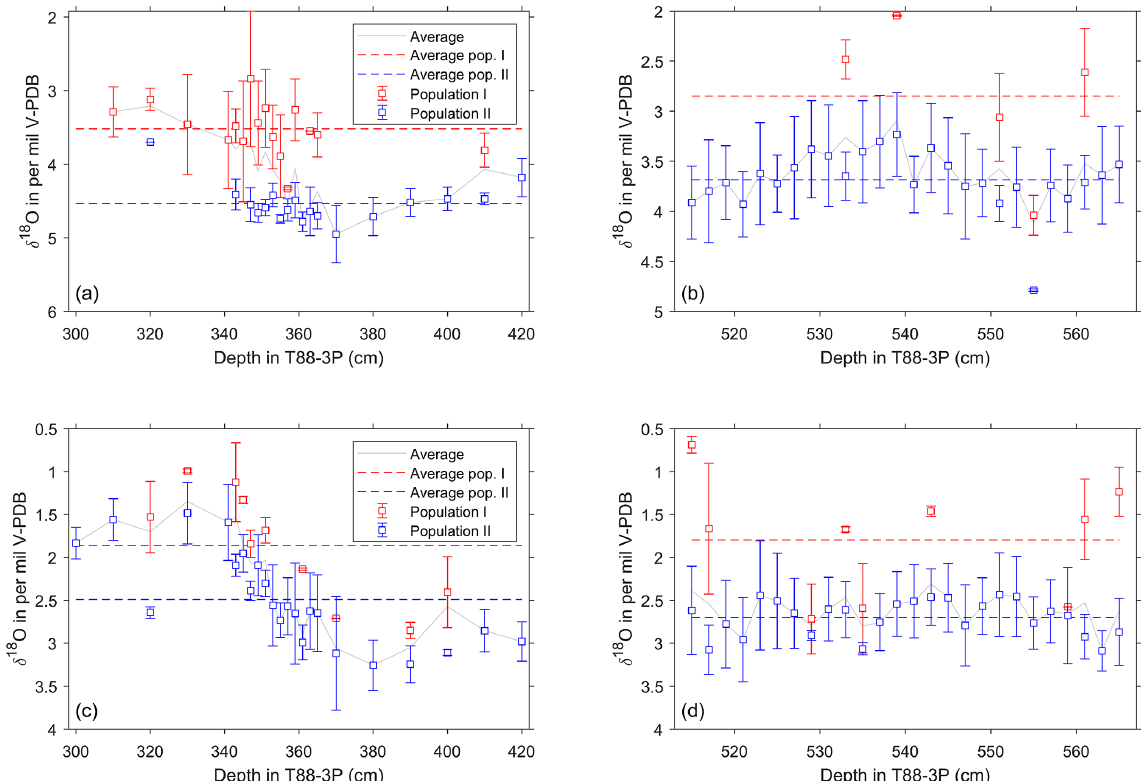
Figure 7. Average δ 18 O value of single-shell populations for specimens of N. pachyderma and G. bulloides across the deglaciation and for the glacial interval. (a–b) Mean and standard deviation of distinct populations of N. pachyderma plotted against core depth. (c–d) Mean and standard deviation of distinct populations of G. bulloides plotted against core depth. Calculated values for P1 and P2, as determined from mixture analysis (Hammer et al., 2001). Vertical bars represent the standard deviation for each population; depths where multiple symbols are present are where it is not possible to distinguish statistically either one or more populations; these thus represent a single population of the sample to the left. Horizontal dashed lines represent the averages for P1 and P2; grey line is the total population average as would be reconstructed from pooled shell analysis. Above 300cm ( < ∼ 10ka), the Holocene, N. pachyderma has disappeared from the